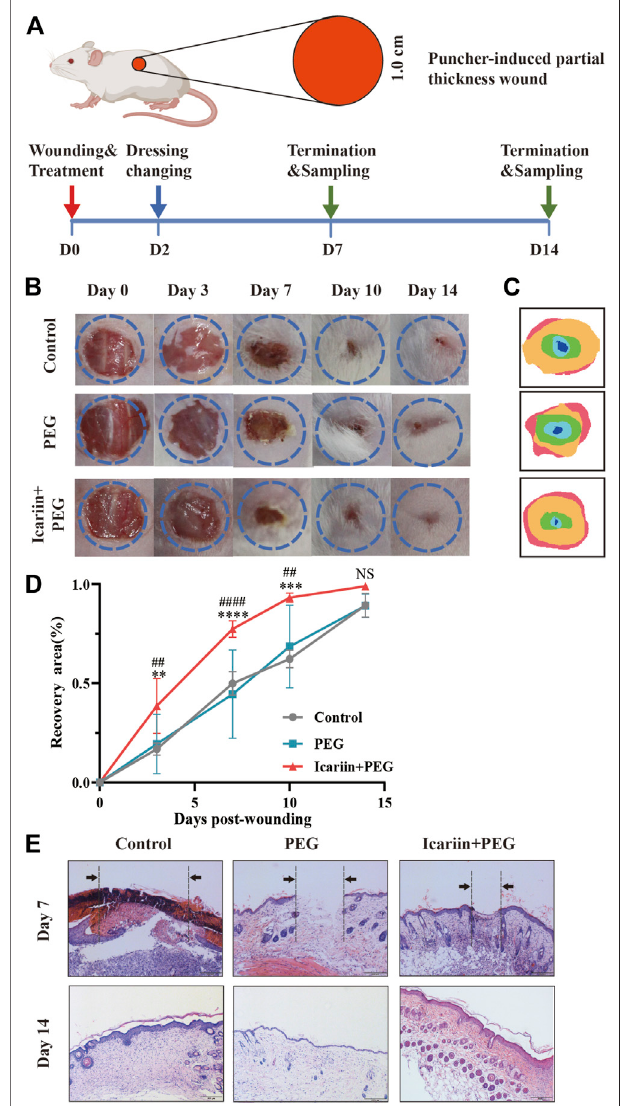
FIGURE2| Icariin+PEGhydrogelspeededupskinrepair. (A) Schematic diagram of the mouse skin full-thickness injury model and experiments in vivo . Acircularwoundof1-cmdiameterwasmadebyusingophthalmicscissorson the back of the mouse. The wounds were observed after application of the hydrogel. On days 7 and 14, the skin tissues were taken for follow-up experiments. (B) Representative images and schematic diagrams of wounds with different treatments: PBS, PEG hydrogel, and icariin+PEG hydrogel dressings. (C) Schematicdiagramofthehealingprocessonday0,3,7,10,14 after wounding was measured by ImageJ. (D) Wound-recovery rates of different treatment groups (control, PEG, and icariin+PEG) over 14 days. n ≥ 4. ** p < 0.005, *** p < 0.0005, **** p < 0.0001 vs . PBS; ## p < 0.005, #### p < 0.0001 vs . PEG. (E) HE staining showing the morphological appearance of skin treated with hydrogels on days 7 and 14. The black arrows and broken lines indicate the edge of the wound visible under a microscope. Scale bar: 200 μ